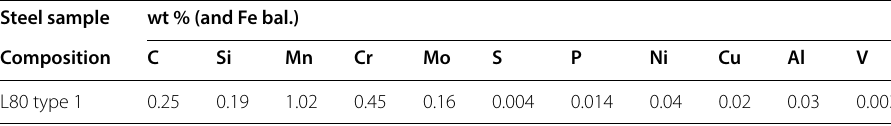
Table 2 Composition of the tested steel grade (API L80 Type 1), as reported by the manufacturer Steel